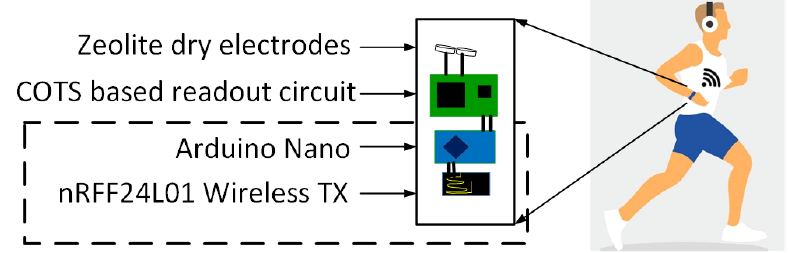
Figure 1. Overview of the ECG wireless SCA transmission